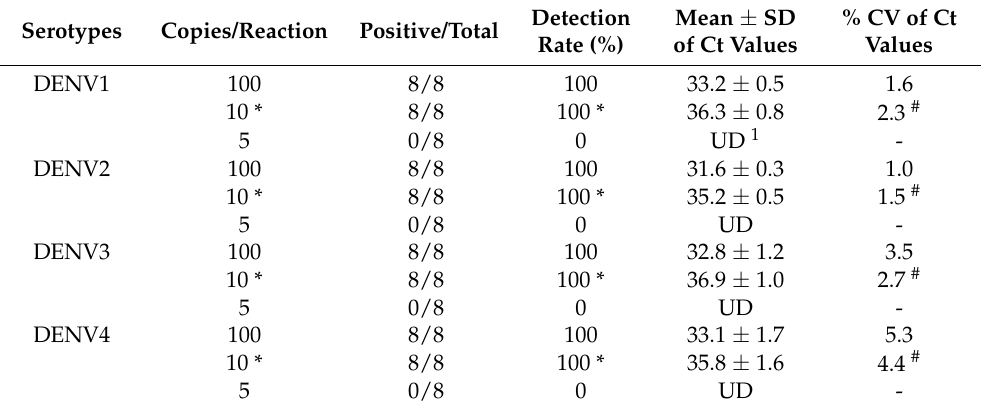
Table 3. Limit of detection and limit of quantification of the 3 (cid:48) -UTR RT-PCR assay. Serotypes Copies/Reaction